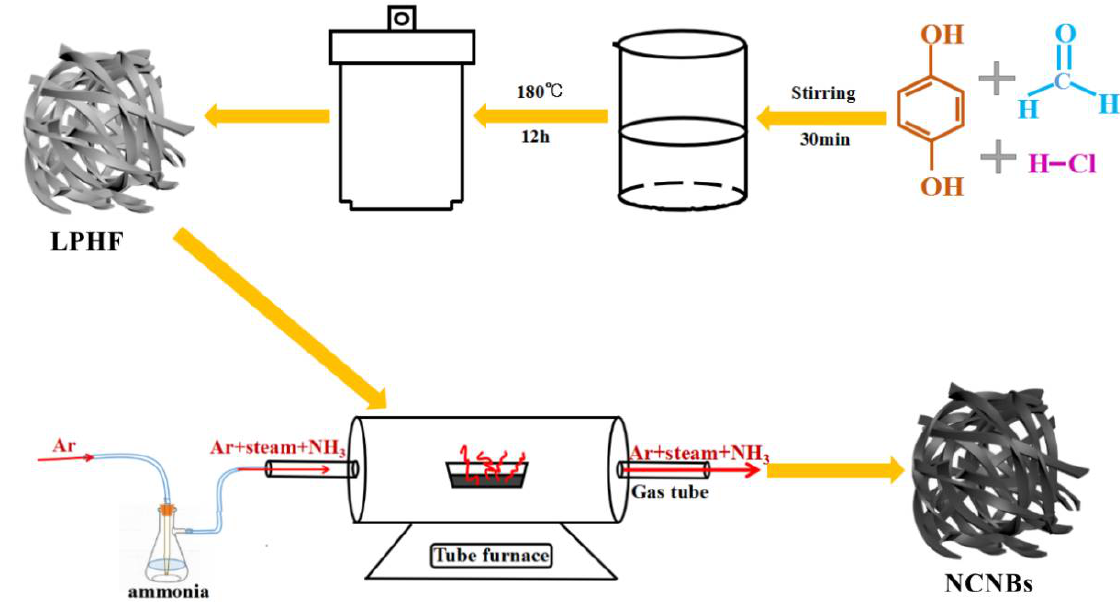
Figure 1. Schematic illustration of the preparation procedure of LPHF and the LPHF was treated by NH 3 ·H 2 O.